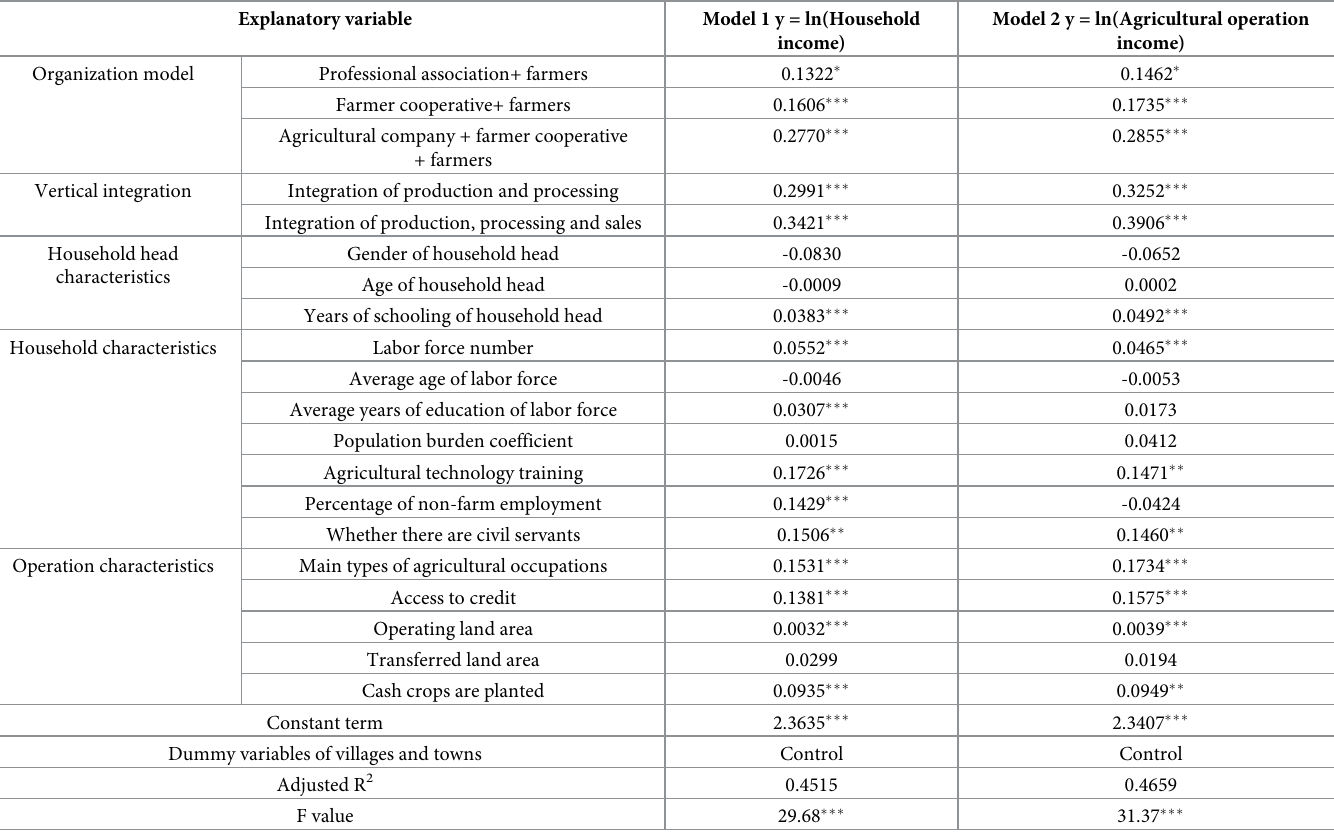
Table 3. Influence of organization model and vertical integration on farmers’ income